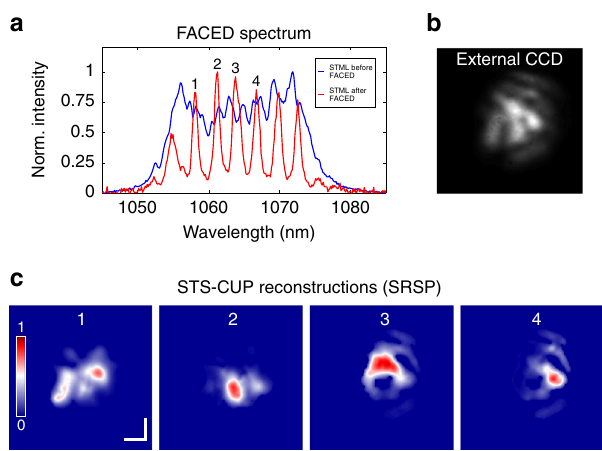
Fig. 5 Spectrally resolved dynamics of a spatio-temporal mode-locking pulse. a Optical spectrum of 3D DSs discretely sampled by the FACED device of STS-CUP, where each peak/component corresponds to a cardinal mode of the FACED “ cavity. ” b Integrated spatial pro fi le measured by an external CCD. c Spectrally resolved spatial pro fi les (SRSP) of a single 3D DS. Here only the modal compositions of four spectral components are given. Scale bar is 400 µ